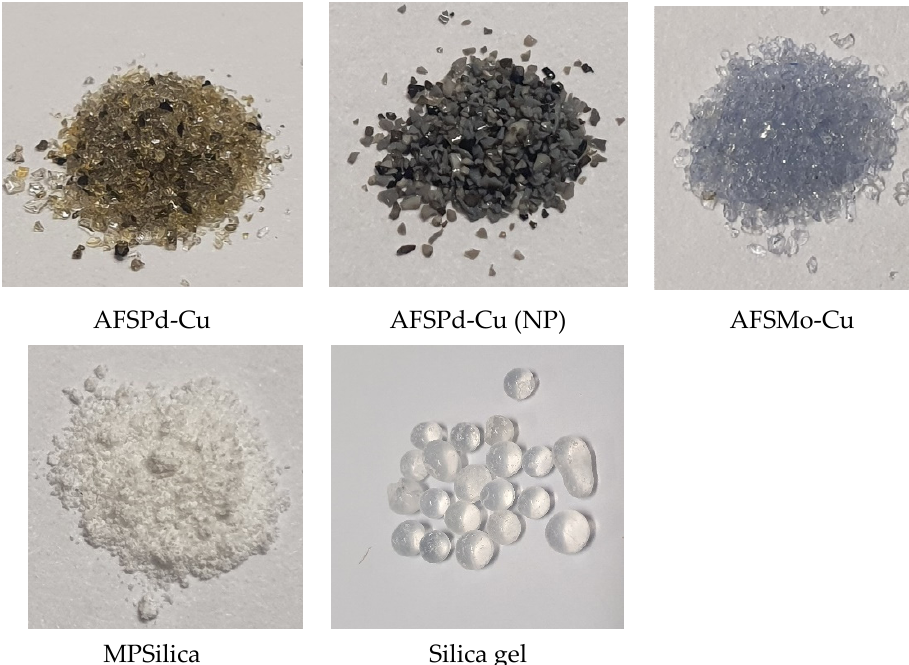
Figure 1. Photographs of the samples analysed in the study.